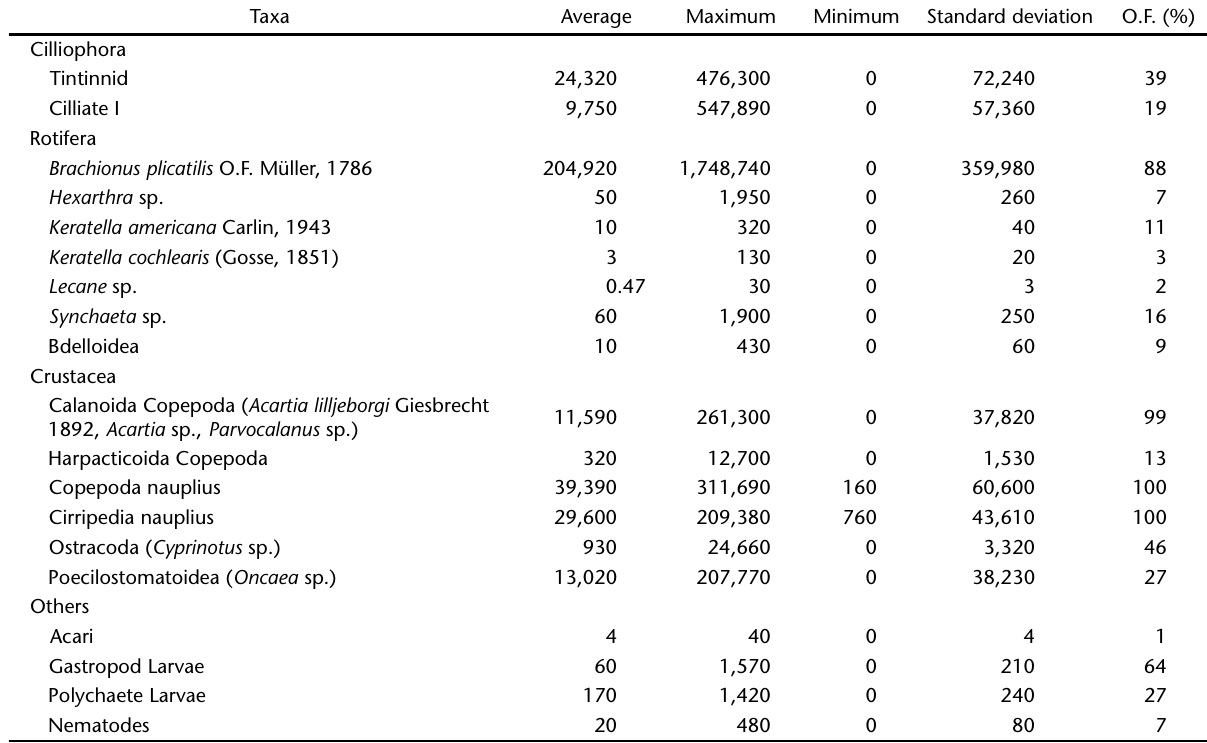
Table I. Abundance (individuals.m -3 ) and occurrence frequency (O.F.) of zooplanktonic taxa in Rodrigo de Freitas